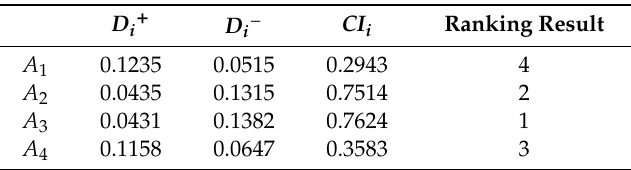
Table 12. The evaluation results based on the relative closeness index.